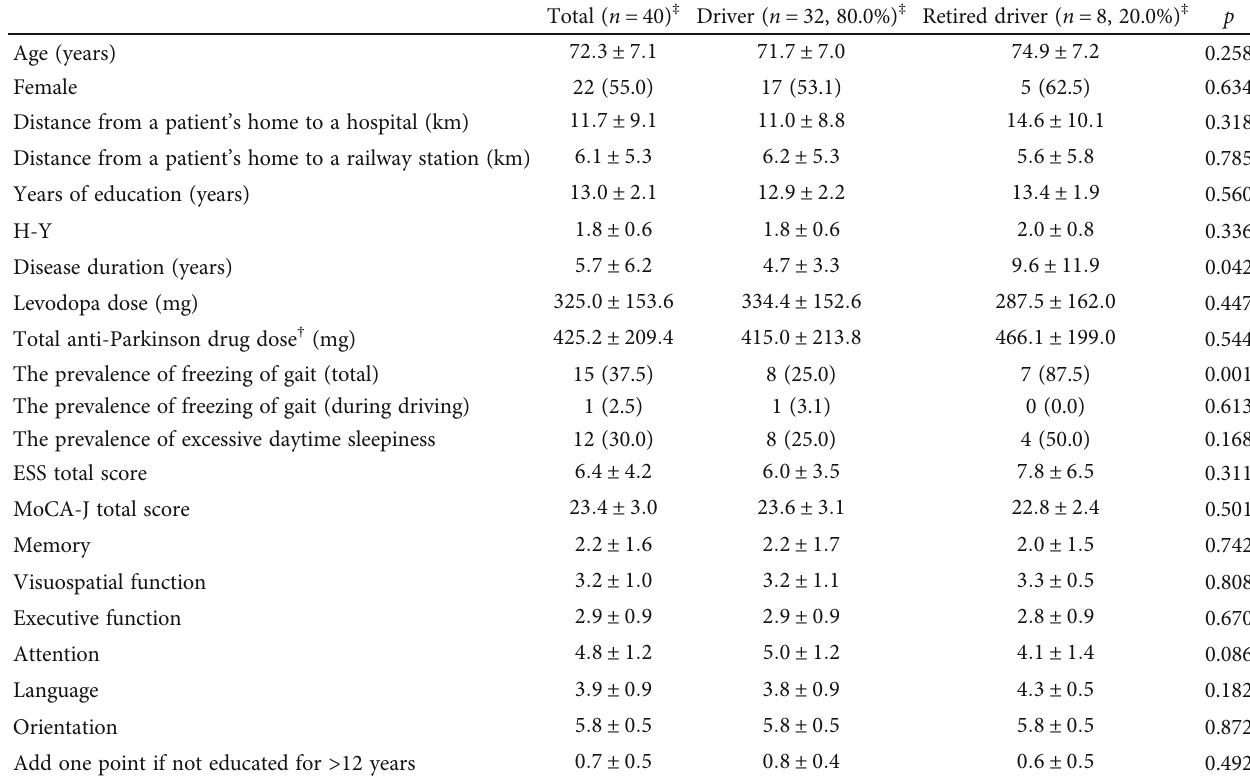
Table 1: Characteristics and scores of MoCA-J of patients with and without driving cessation.